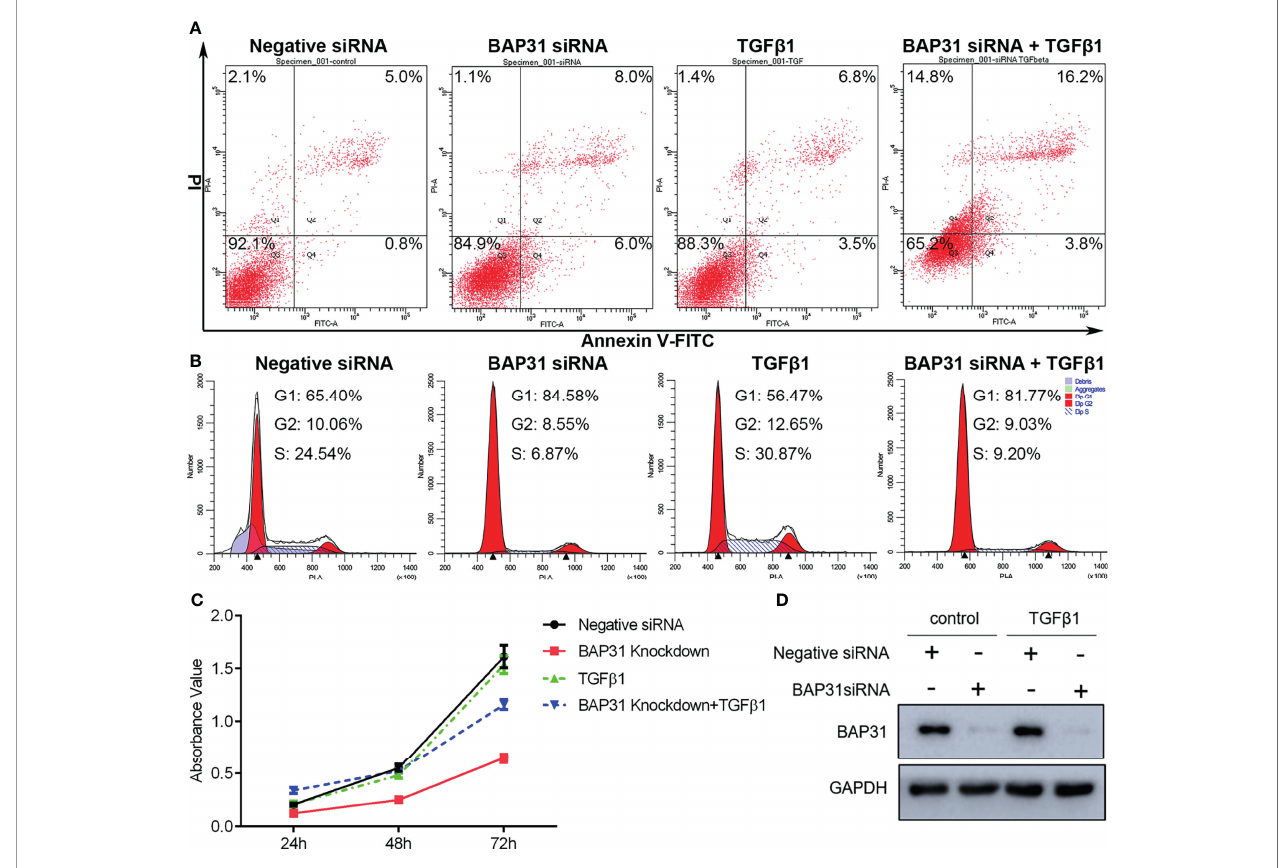
FIGURE 6 | The survival of A549 lung cancer cells with BAP31 siRNA knockdown and TGF b treatment. (A) Apoptosis was determined by annexin V-FITC/PI staining using fl ow cytometry. (B) Cell cycle distribution was examined by PI staining using fl ow cytometry. (C) The cell survival was examined by the CCK-8 assay. (D) Expression of BAP31 as evaluated by Western blot